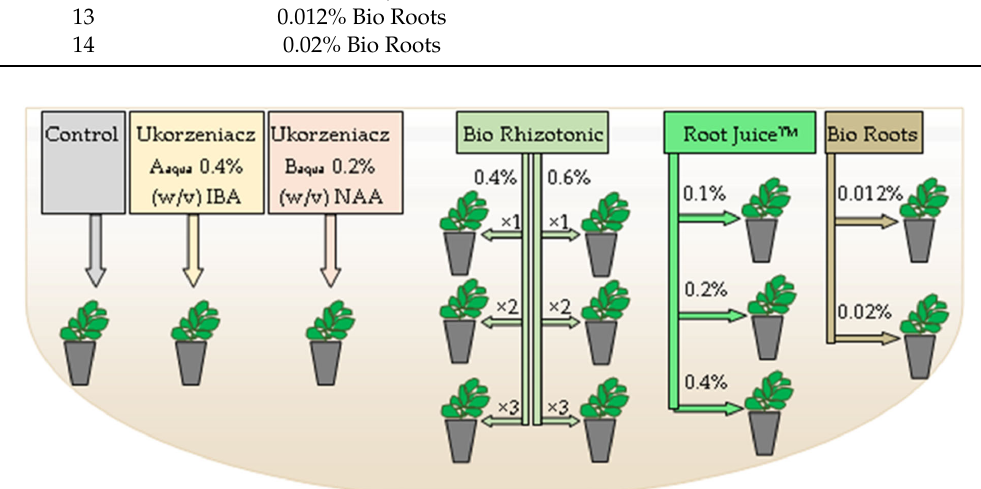
Figure 2. The scheme of the experiment treatments of rose cuttings with rooting stimulants in each of four shoot phenological stages.